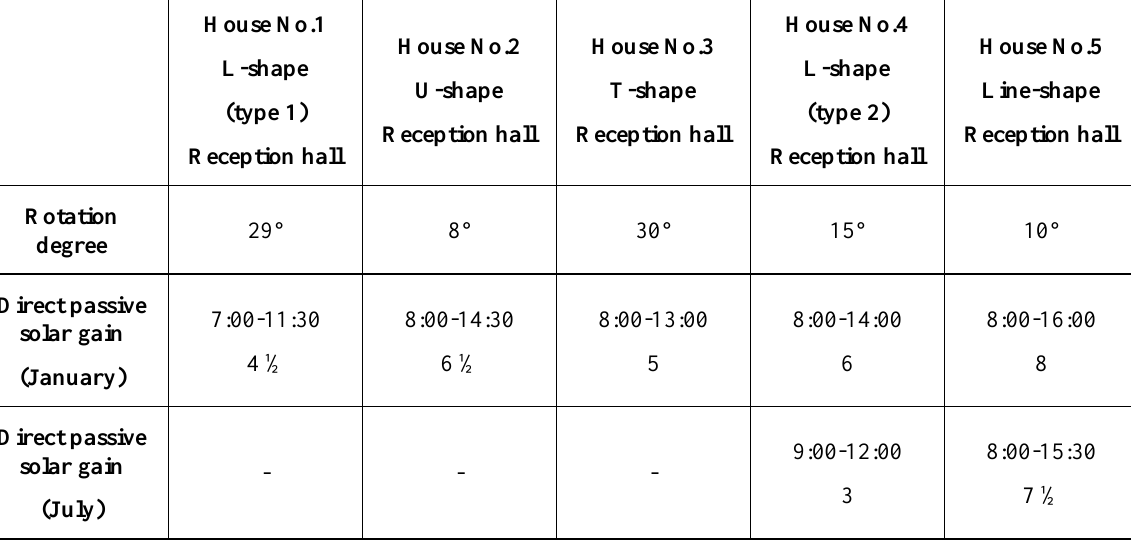
Table 4 Hours of direct solar radiation for houses No.1-5 regarding the secondary living space (Source: